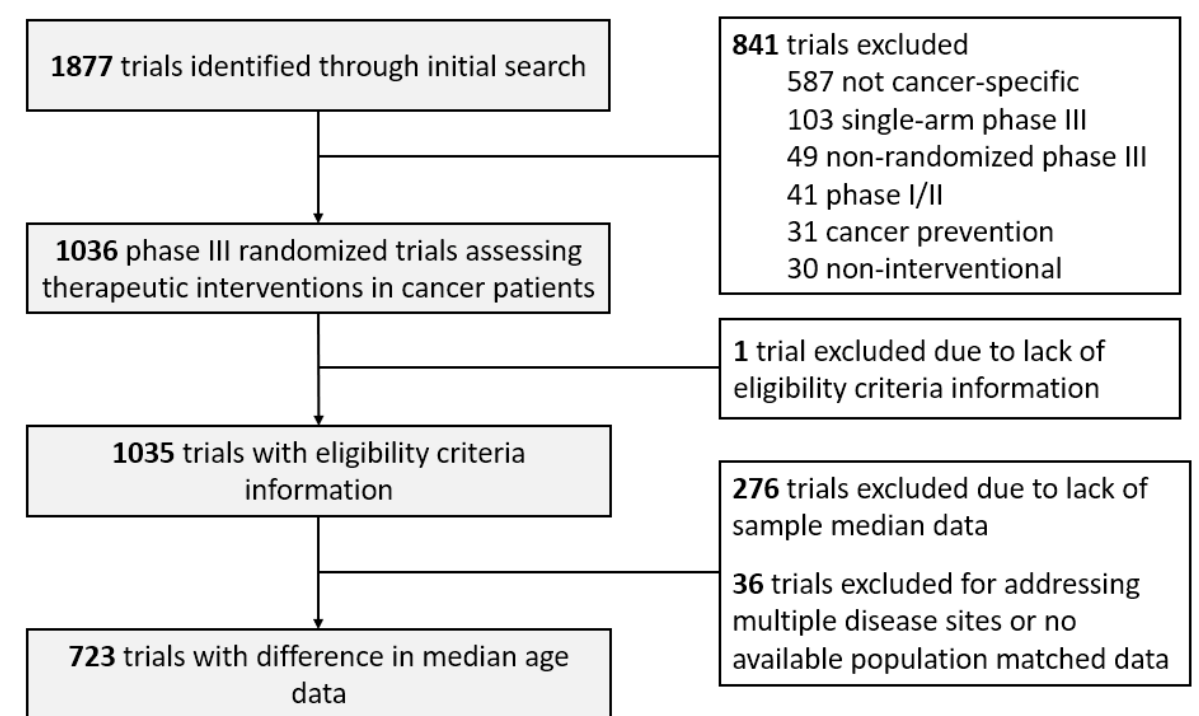
Figure 1. Trial selection criteria for PMEC and DMA analyses.